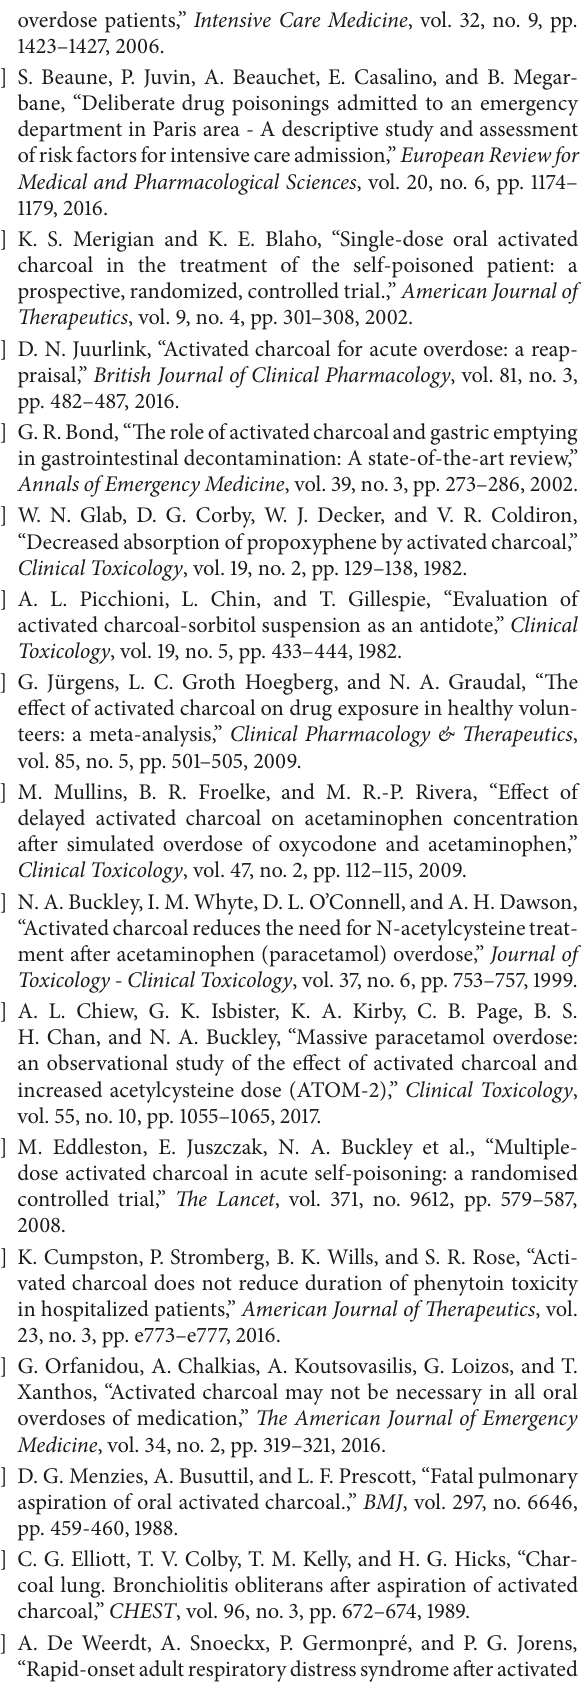
Supplemental Table 1 : time delay from drug exposure to presentation. Supplemental Table 2 : major toxic agents